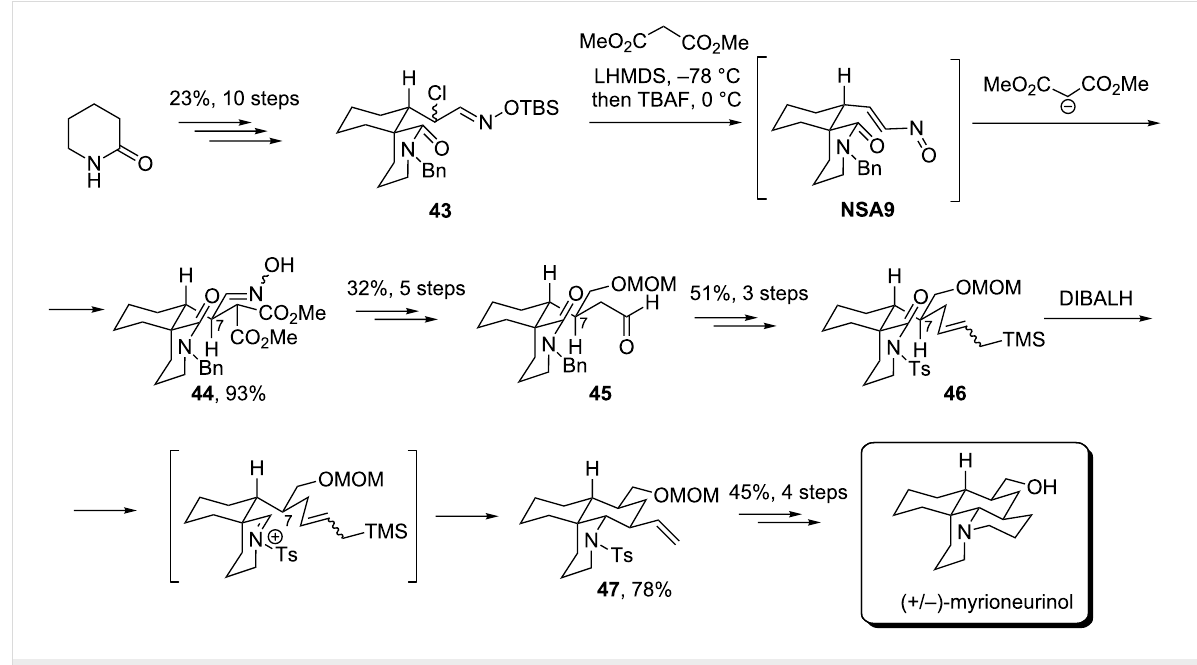
Addition of organometallic reagents to conju- gated